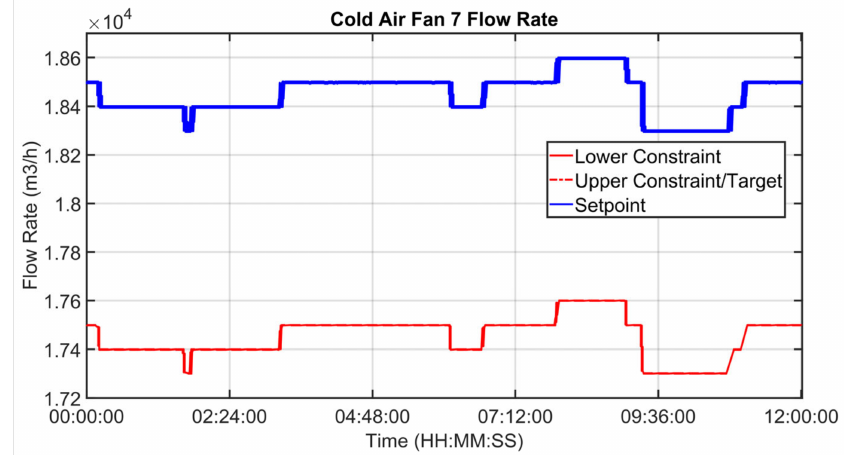
Figure 34. Grate cooler APC system: field results (cold air fan 7 flow rate MV).